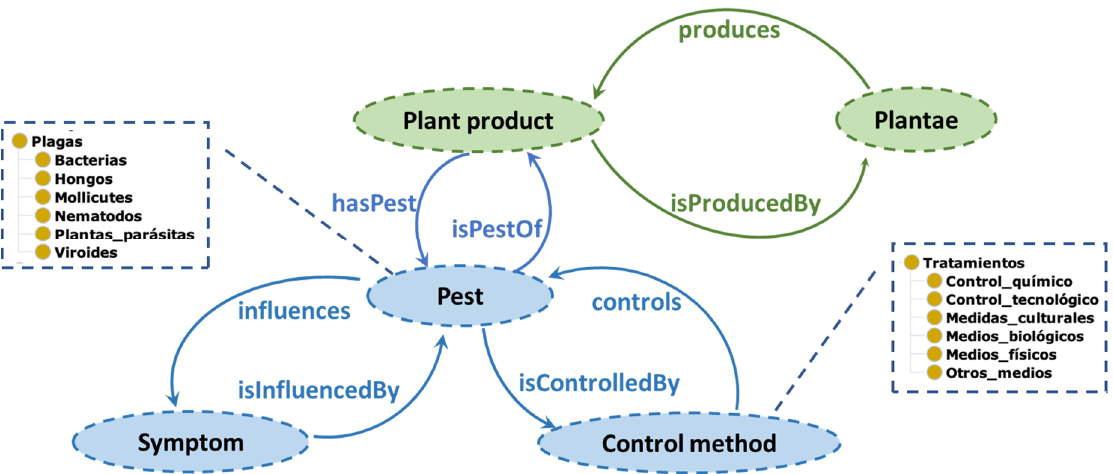
Figure 2. Ontology’s high-level classes and their relationships (partially in